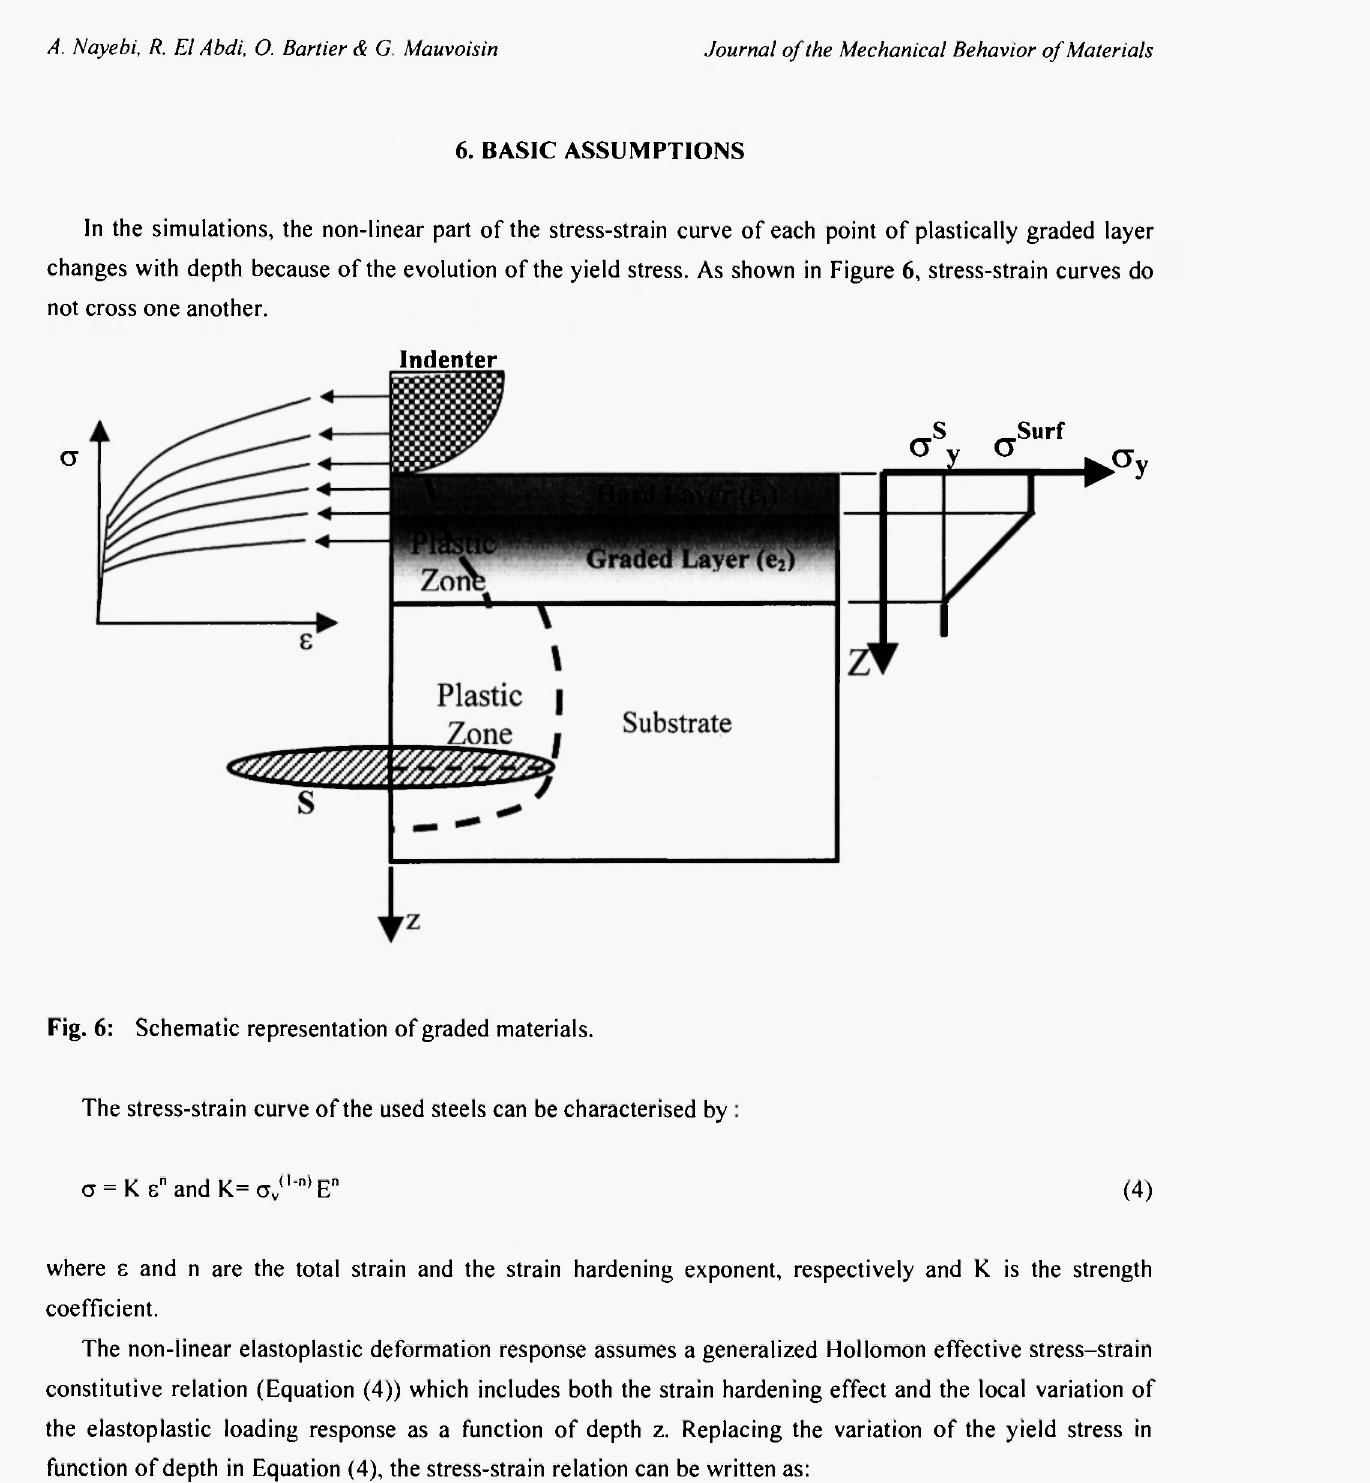
Fig. 6: Schematic representation of graded